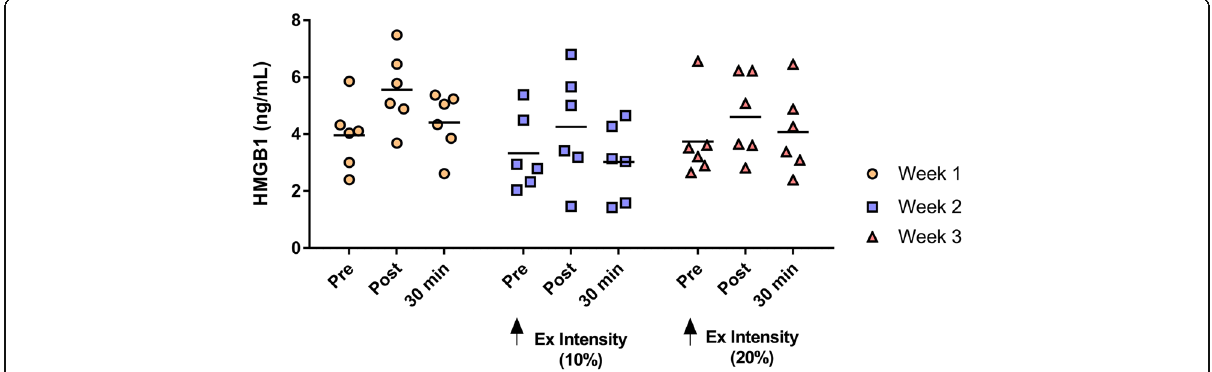
Fig. 3 Plasma [HMGB1] during 3weeks of exercise training. Data showed a significant main effect of time ( P =0.028) but Post hoc Tukey ’ s multiple testing did not show statistical significance in mean HMGB1 within each week. No significant main effect of intensity or interaction was detected ( P >0.05). Pre , Post and 30min are timepoints of blood sampling before, immediately after, and 30min after the exercise bout